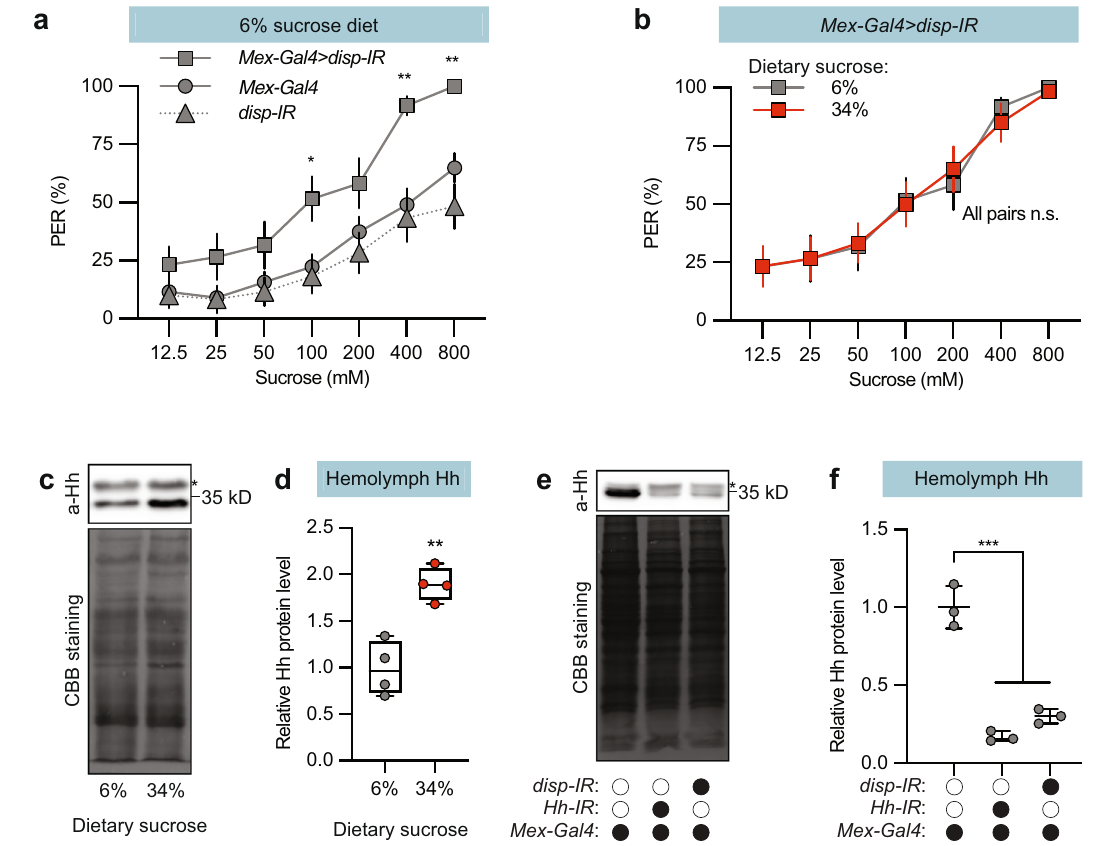
Fig.4|Gut-derivedHhissecretedintothehaemolymph.a Knockdownof disp in gut enterocytes ( Mex > disp-IR) signi fi cantly increased sucrose-induced PER. b Mex > disp-IR fl ies showed a similar PER % when reared on the indicated sugar diets. c Anti-Hh immunoblot of total protein from the hemolymph of w 1118 males reared on the indicated diets. The asterisk indicates a nonspeci fi c band. Staining with Coomassie brilliant blue (CBB) serves as a loading control (below). d Plot showing the quanti fi cation of circulating Hh levels in c . n =4. Median (middle line) is depicted,and whiskersrepresent minimumto maximum. e Anti-Hhimmunoblot of totalprotein from the hemolymph of the indicated genotypes.Flies werereared